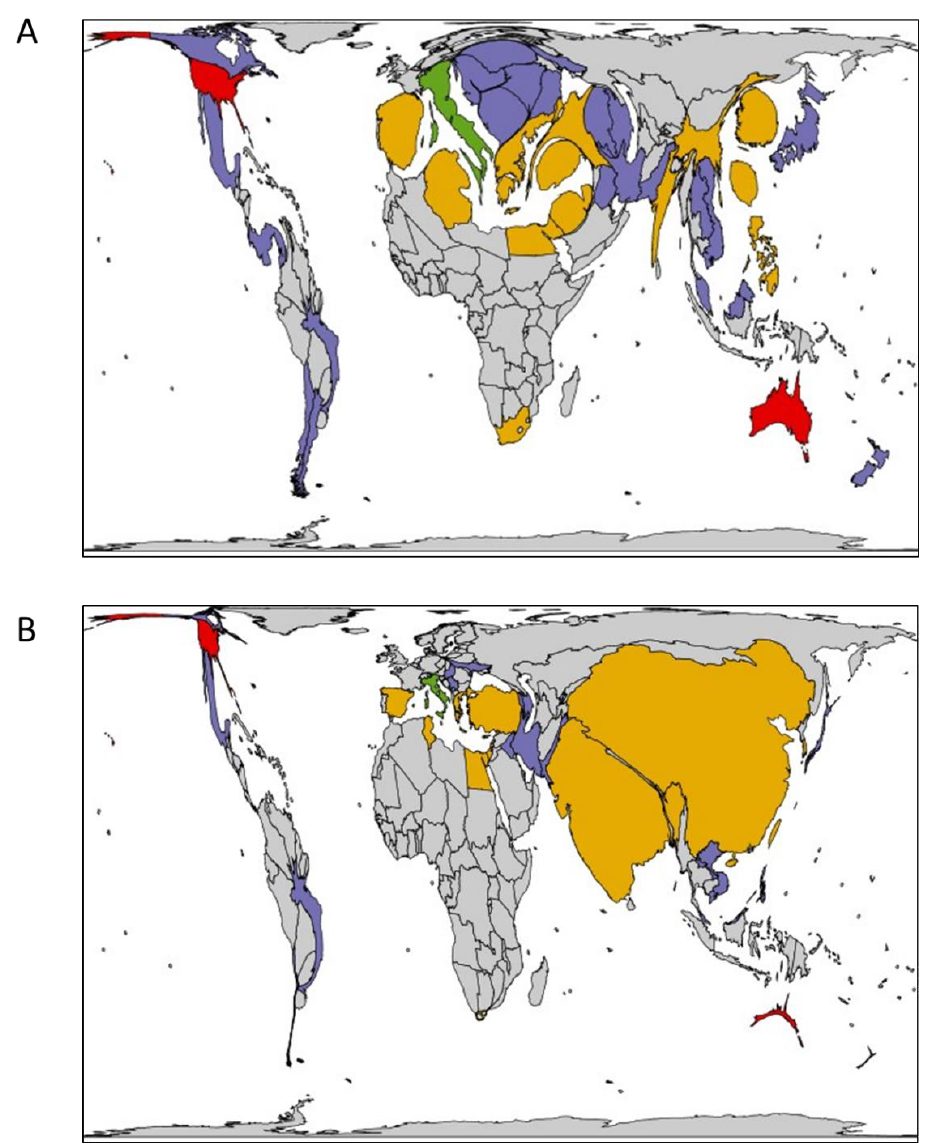
Figure 3. Global Fon distribution. Countries are colored based on highest race detected: green, race 1; yellow, race 2; red, race 3; and purple, race not reported. ( A ) Country area proportional to watermelon yield (hg/hectare), and ( B ) country area proportional to watermelon production (metric tons). Images produced using an online program which scales images depending on a determined variable while maintaining the original object boundaries as computed by a flow-based algorithm [27].